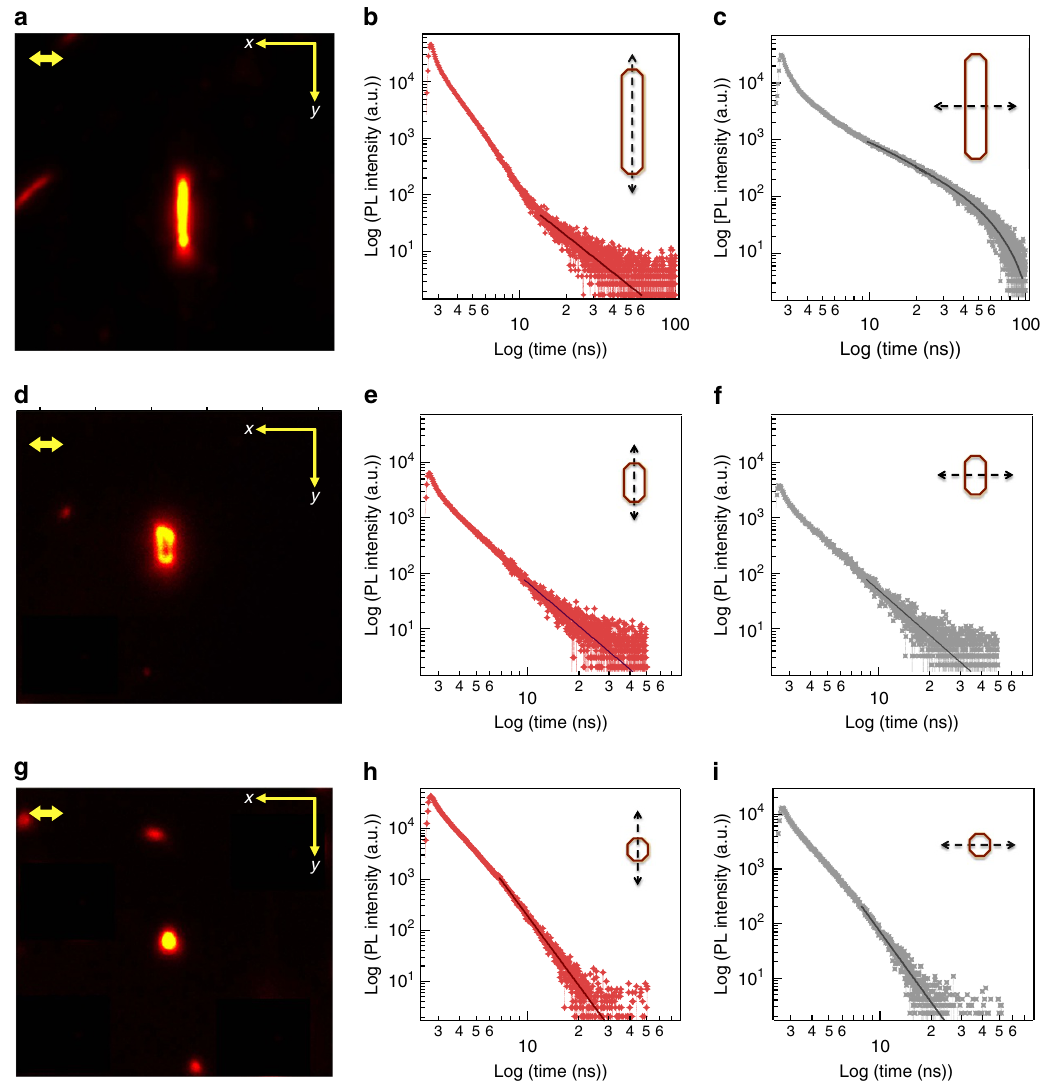
Figure 5 | Time- and polarization-resolved PL decay dynamics with varying crystal aspect ratio. ( a , d , g ) PL images of TAT nanowire, crystal and nanocrystallite, respectively, Scale bar, 300nm. ( b , c , e , f , h , i ) X- and Y-polarized PL decays from nanowire, crystal, and nanocrystallite for excitation along the y axis. For the nanowire ( a ), the Y-polarized PL ( b ) follows a power-law decay ( m ¼ 2.3), while the X-polarized PL decay ( c ) is bi-exponential ( g 1 ¼ 5.1ns and g 2 ¼ 20.2ns). For the crystal ( d ), both polarization channels ( e , f ) show power-law decay with m X ¼ 2.7 and m Y ¼ 2.6. For the nanocrystallite ( g ), luminescence also follows a power-law decay in both polarization channels ( h , i ) with m X E m Y ¼